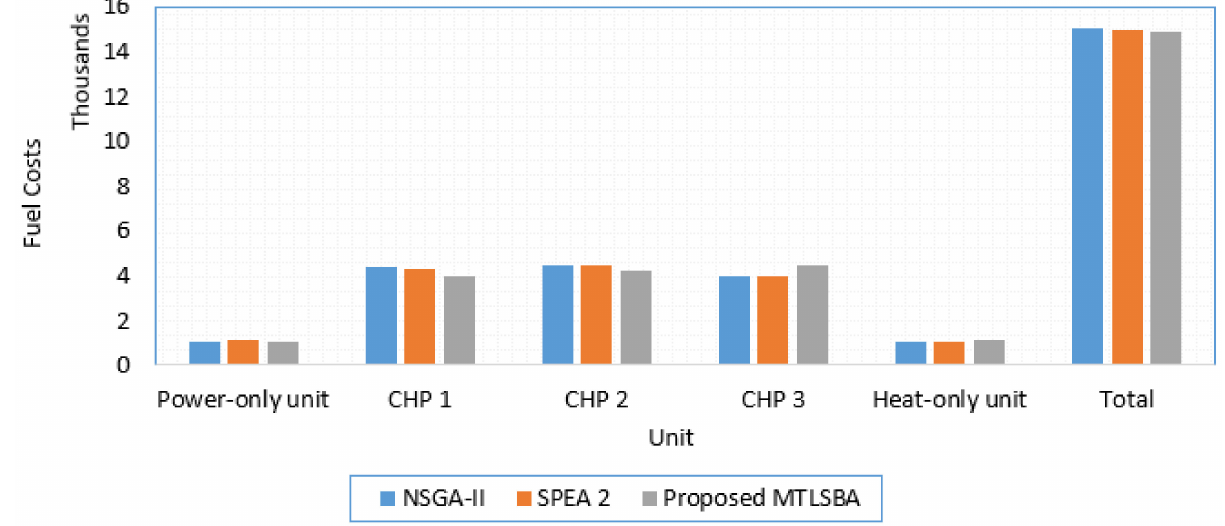
Figure 9. Fuel costs for each unit related to the best compromise results in Table 3.